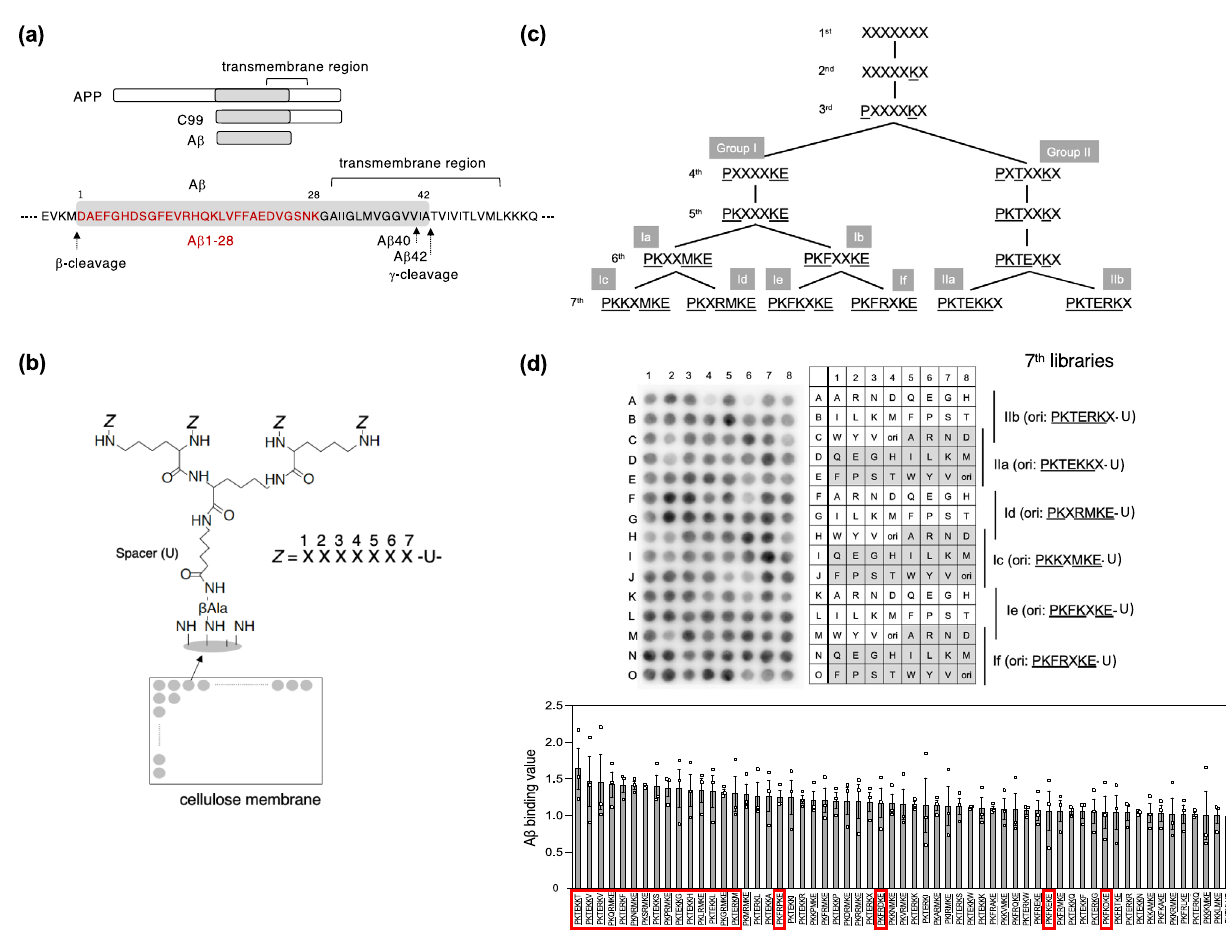
Fig. 1 Af fi nity-driven screening of tetravalent peptide libraries synthesized on a membrane identi fi ed a series of A β 1 – 28 binding peptides. a Schematic diagram of amyloid precursor protein (APP), C-terminal fragment β (C99), and amyloid- β peptide (A β ). b Schematic showing the structure of our tetravalent peptide library synthesized on a cellulose membrane. The library for the fi rst round of screening contained tetravalent peptides with the sequence X-X-X-X-X-X-X-U- (where X is a mixture of all amino acids except Cys, and U is amino hexanoic acid as a spacer), and each X was replaced individually by a fi xed amino acid, excluding Cys (Supplementary Fig. 1a). Membranes were blotted with biotinylated A β 1 – 28 (10 µ g/ml), and binding of A β 1 – 28 to each tetravalent peptide was analyzed, as described in detail in the Methods and in Supplementary Fig. 1a. c Schematic outline of the af fi nity- based maturation of A β 1 – 28-binding motifs. The second library was designed based on the motif obtained from the fi rst screen. Similarly, fi ve additional rounds of af fi nity-based screening were performed to maturate the binding motifs and generate the seventh libraries (Supplementary Fig. 1b – j). d The library for the seventh round of screening contained peptides with following sequences: P-K-K-X-M-K-E-U- (7 th Ic), P-K-X-R-M-K-E-U- (7 th Id), P-K-F-K-X- K-E-U- (7 th Ie), P-K-F-R-X-K-E-U- (7 th If), P-K-T-E-K-K-X-U- (7 th IIa), or P-K-T-E-R-K-X-U- (7 th IIb), where each X was replaced individually by a fi xed amino acid, other than Cys; “ ori ” indicates the original motif. The binding of A β 1 – 28 to each tetravalent peptide was analyzed, as described above, and each screen was performed three times; a representative blotted membrane is shown (upper panel). Mean A β -binding values for the top 60 motifs, ± the standard error (SE), are shown in the lower panel ( n = 3). The top 15 motifs were selected as candidates, and four additional motifs were selected from groups Ie and If, as no motifs from these groups were represented in the top 15; selected motifs are boxed in